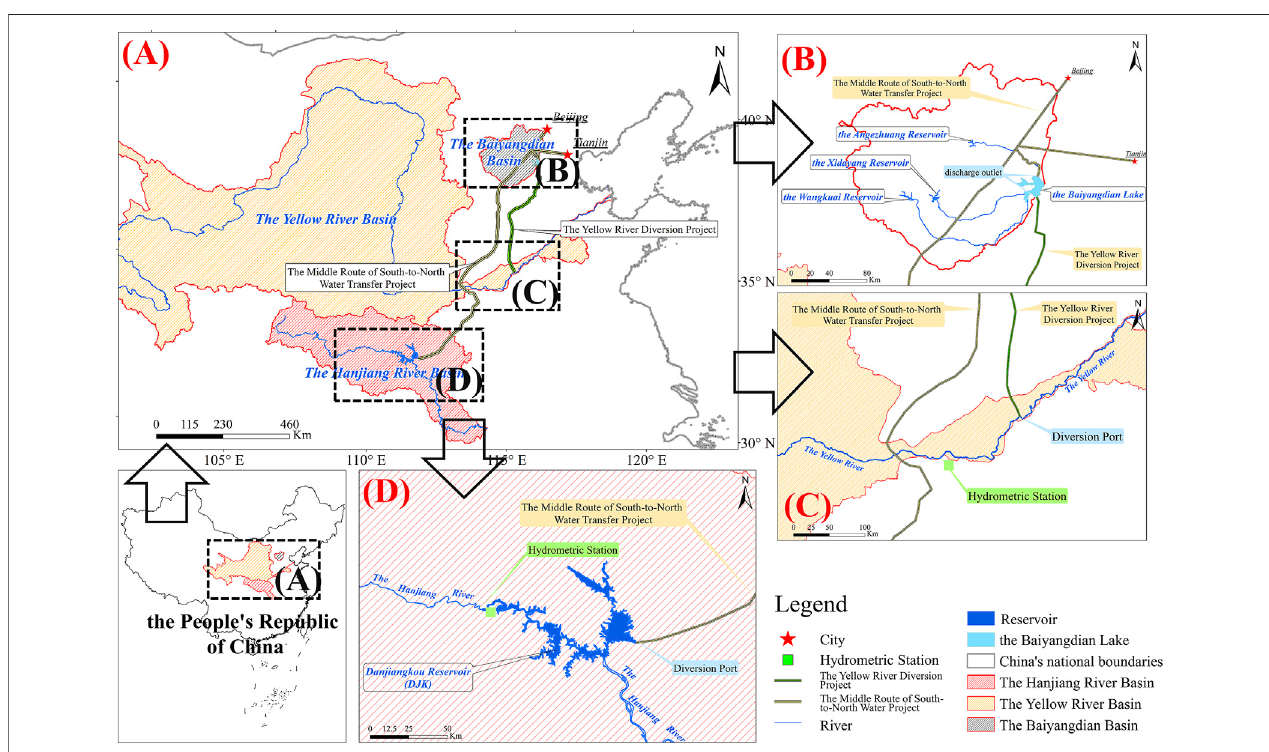
FIGURE 2 | Location of the research